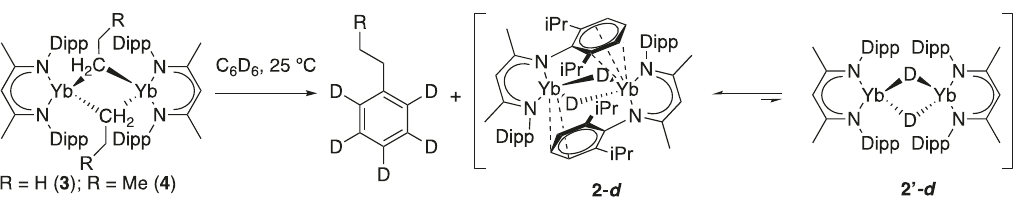
Fig. 4 Reaction of ytterbium alkyls with benzene. The addition of benzene to compound 3 at room temperature provides ethylbenzene and the ytterbium deuteride complex 2 -d . The addition of benzene to compound 4 at room temperature provides n -propylbenzene and the ytterbium deuteride complex 2 -d .